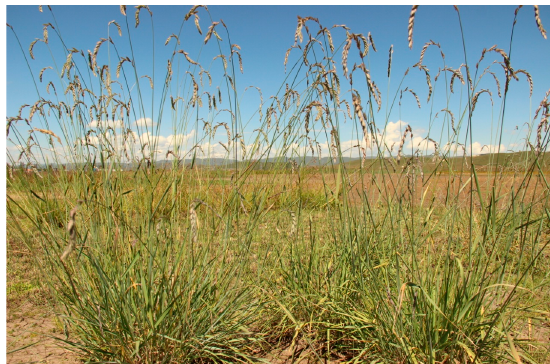
Figure 1. Kengyilia melanthera . cv. Aba.